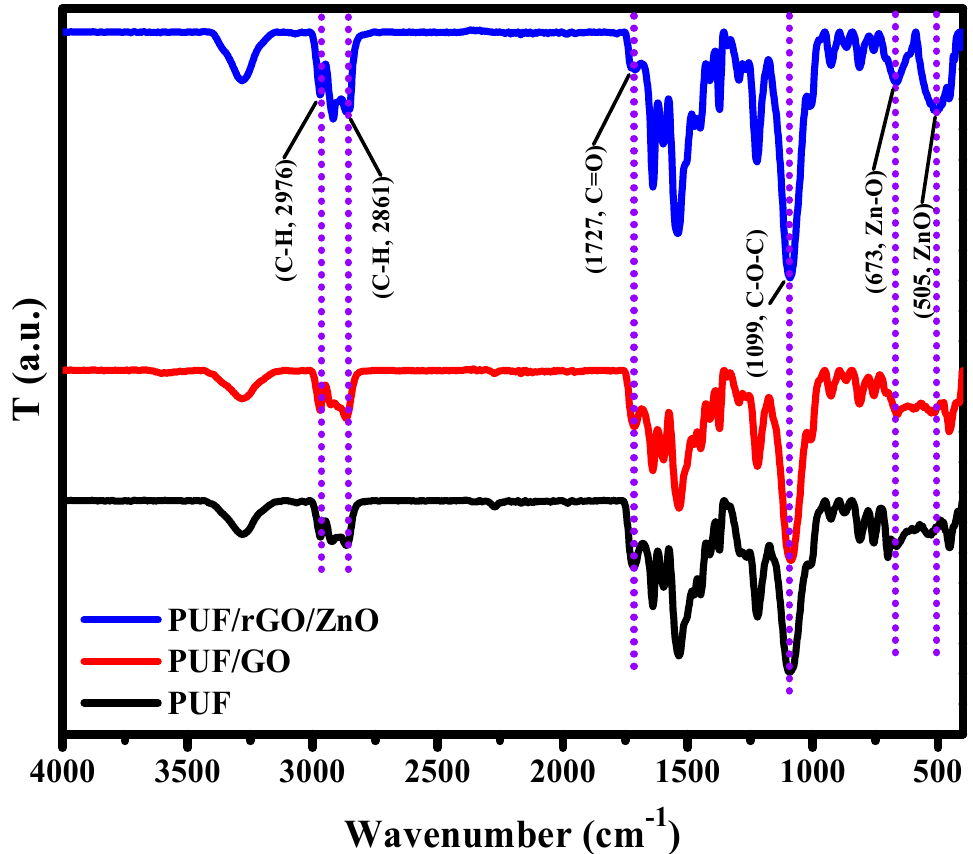
Figure 3. FTIR spectra of neat PUF, PUF/GO, and PUF/rGO/ZnO nanocomposites.